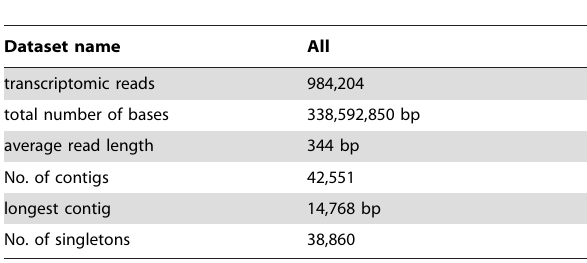
Table 1. Summary of Roche 454 GS FLX assembly and analysis of M. nipponense transcriptomic